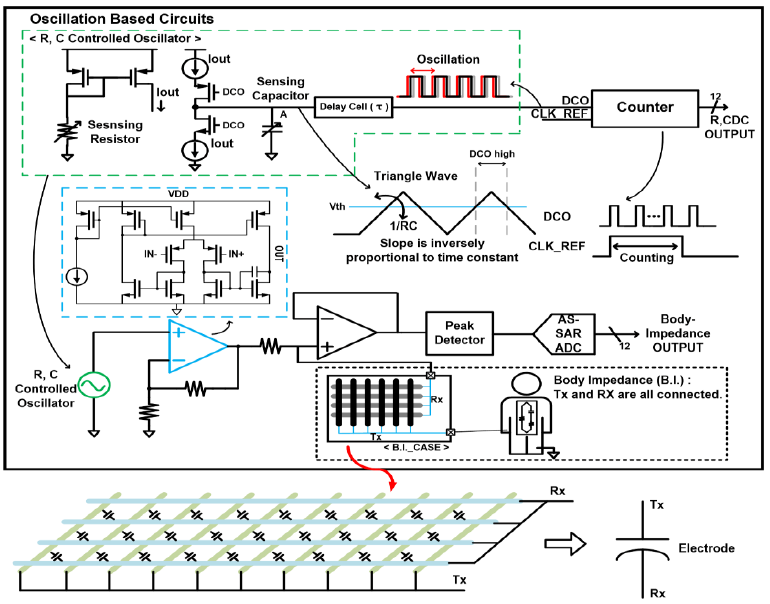
Figure 3. Oscillator-based multi-sensor interface configuration and readout circuit.